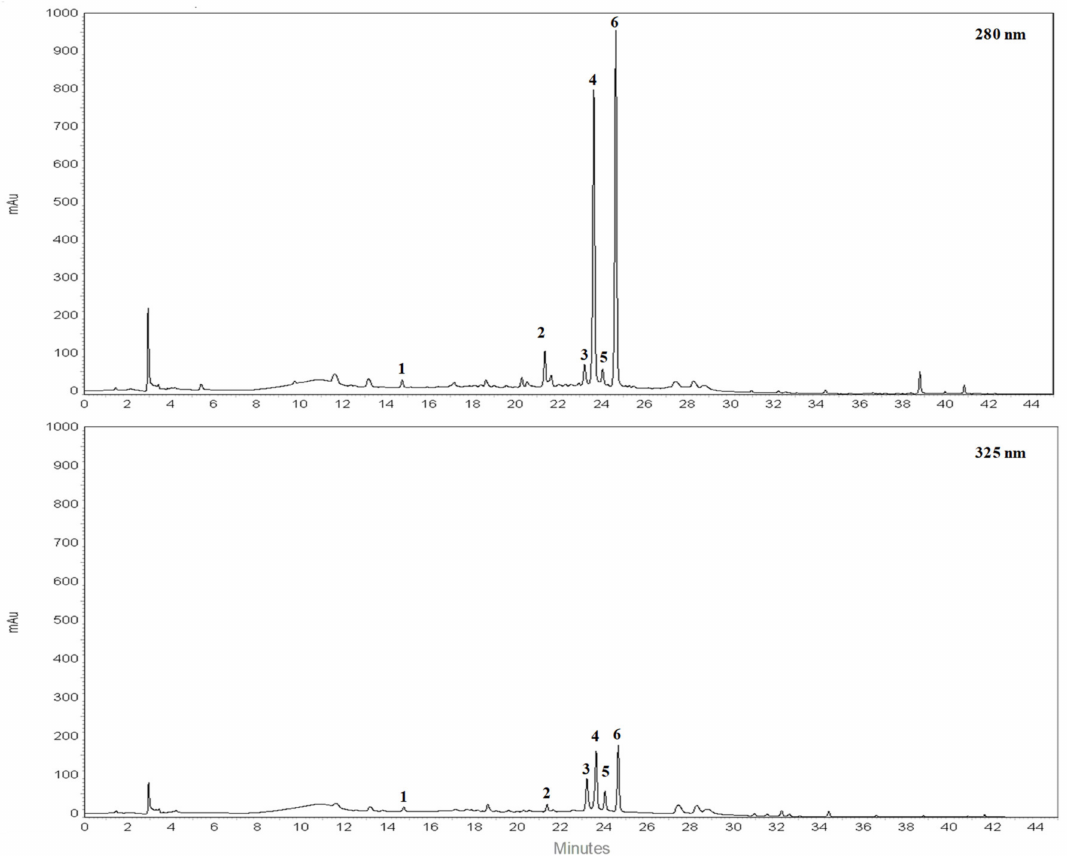
Figure 1. Representative chromatograms of flavonoid composition of BJe. Reverse phase diode array detector high performance liquid chromatography (RP-HPLC-DAD) separation of compounds present in the lyophilized powder recorded at 280 nm and 325 nm. Flavonoids corresponding to peaks 1–6, expressed in milligrams (mg) per milliliter (mL) of liquid extract, are the following: vicenin-2 ( 1 ), neoeriocitrin ( 2 ), rhoifolin ( 3 ), naringin ( 4 ), neodiosmin ( 5 ) and neohesperidin ( 6 ). Peak identification was performed by comparing retention time, UV spectra and spiking the samples with pure reference